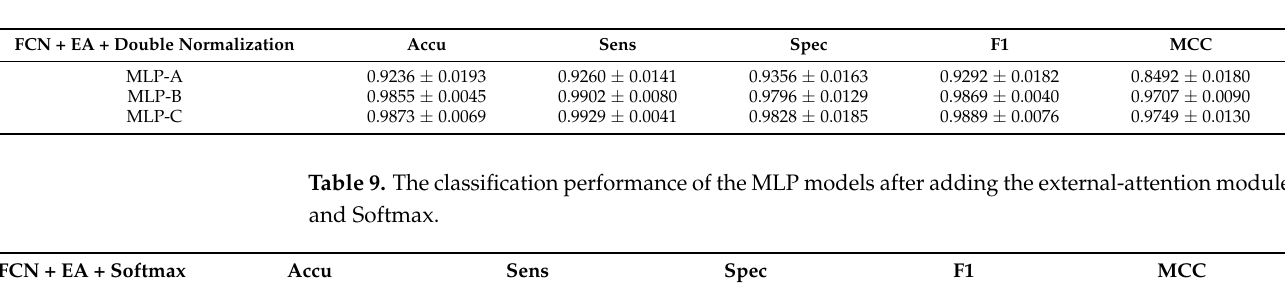
Table 8. The classification performance of the MLP models after adding the external-attention module and double normalization.